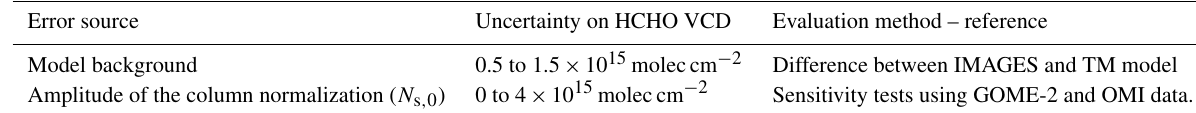
Table 9. Estimated errors on the reference sector correction.